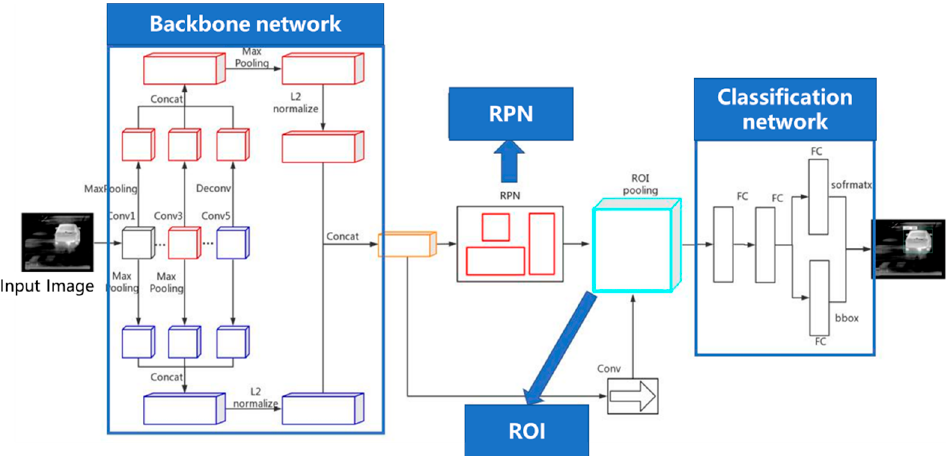
Figure 1. CMF Net architecture.